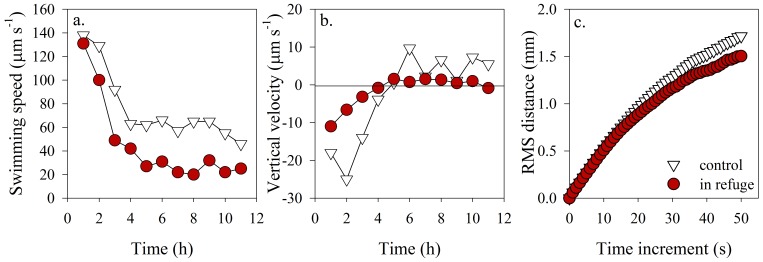
Above halocline movement behaviors.Mean (a) swimming speed (µm s−1), (b) vertical velocity (µm s−1) and (c) root mean square distance (RMSD) (mm) of H. akashiwo in the absence (white triangles) and presence of the predator (red circles) above the halocline. Movement behaviors reflect significantly more retentive swimming above the halocline in response to the presence of the predator below the halocline.